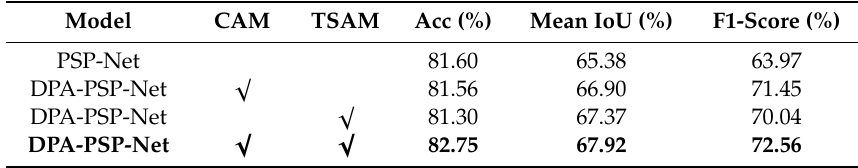
Table 4. Ablation study for di ff erent attention module combinations.